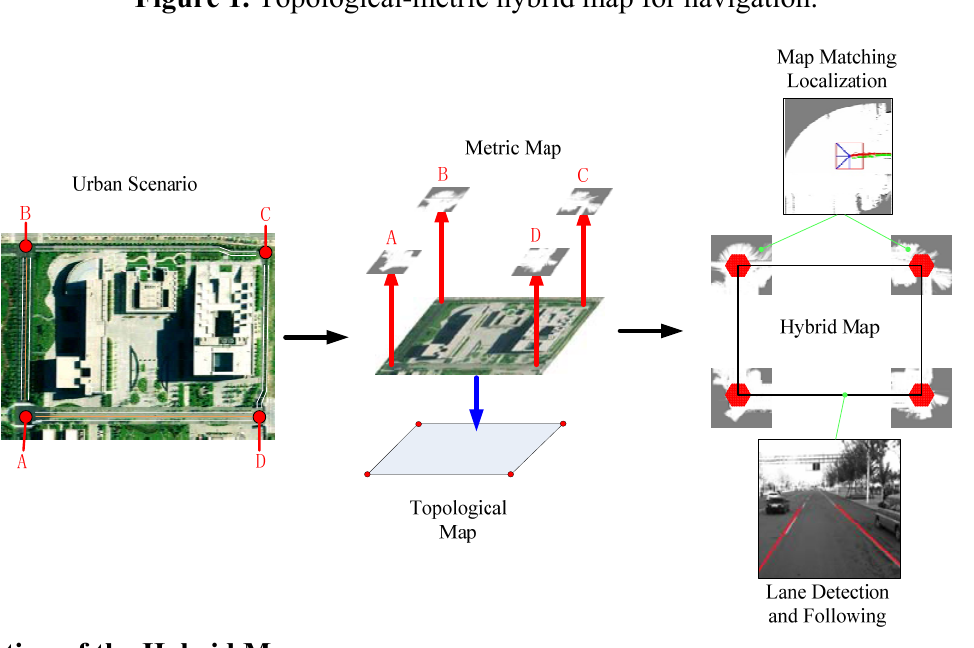
Figure 1. Topological-metric hybrid map for